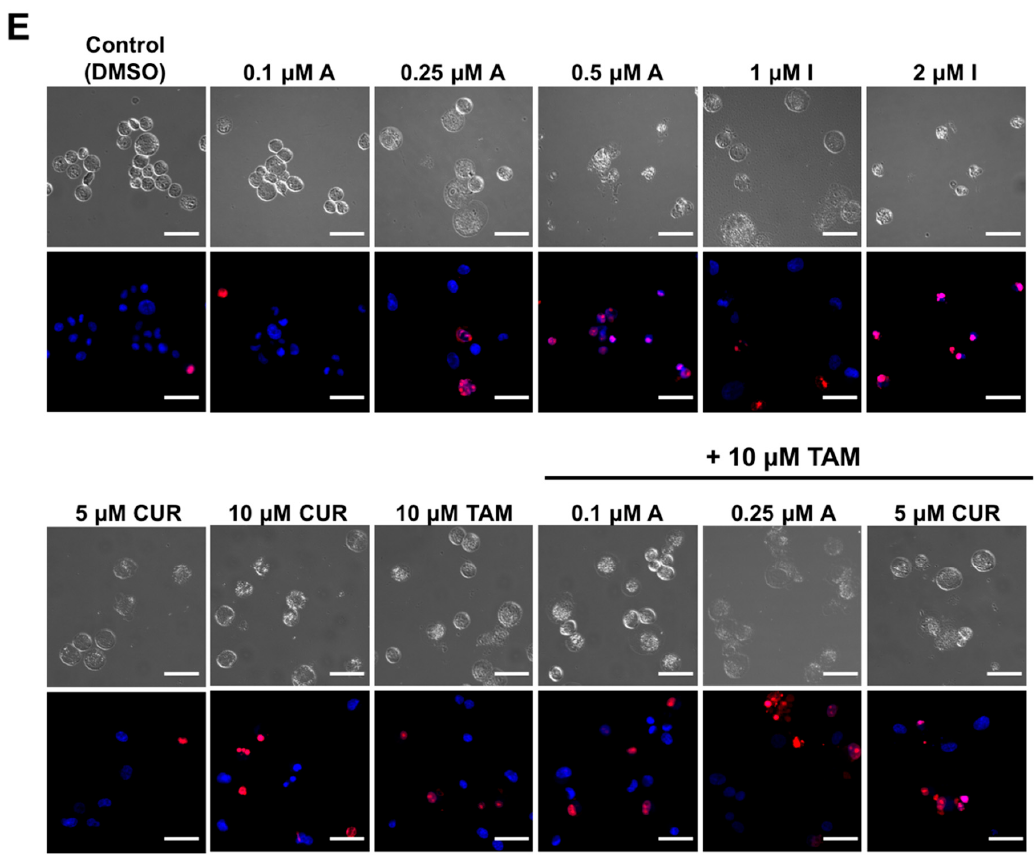
Figure 4. Compounds A and I induce apoptosis selectively and Compound A interacts positively with tamoxifen. ( A ) A375 melanoma cells and ( B ) noncancerous normal human fibroblasts (NHF) were treated with the indicated compounds for 48 h then stained with Annexin V and PI to quantify apoptosis, as described in the materials and methods section. Image based cytometry was utilized to assess apoptosis. The y -axis represents the percent of cells positive for Annexin V (green), PI (red), Annexin V and PI (orange), or cells negative for Annexin V and PI (blue). Values are expressed as mean ± SD from three independent experiments. ( C ) A375 melanoma cells and ( D ) NHF cells were treated with Compound A and curcumin alone and in combination with tamoxifen for 48 h. Please note, the data of Compound A and curcumin alone shown in Figure 4A,B were used again in Figure 4C,D, respectively along with the combination treatments for direct comparison. * p < 0.05 vs. DMSO control (comparison of viable cells only); ** p < 0.01 vs. DMSO control (comparison of viable cells only); *** p < 0.001 vs. DMSO control (comparison of viable cells only); **** p < 0.0001 vs. DMSO control (comparison of viable